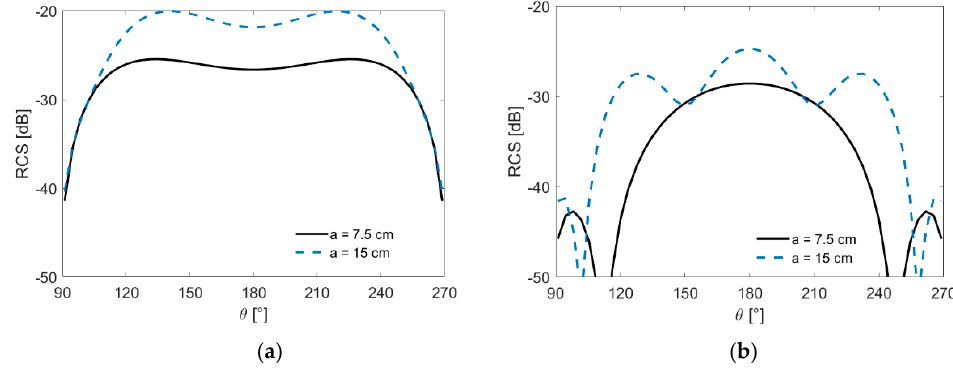
Figure 6. Radar cross sections as a function of the scattering angle h at 1 GHz: ( a ) ε rc = 50, S = 1 S/m (biological medium); and ( b ) ε rc = 2.5, S = 0.005 (wood).